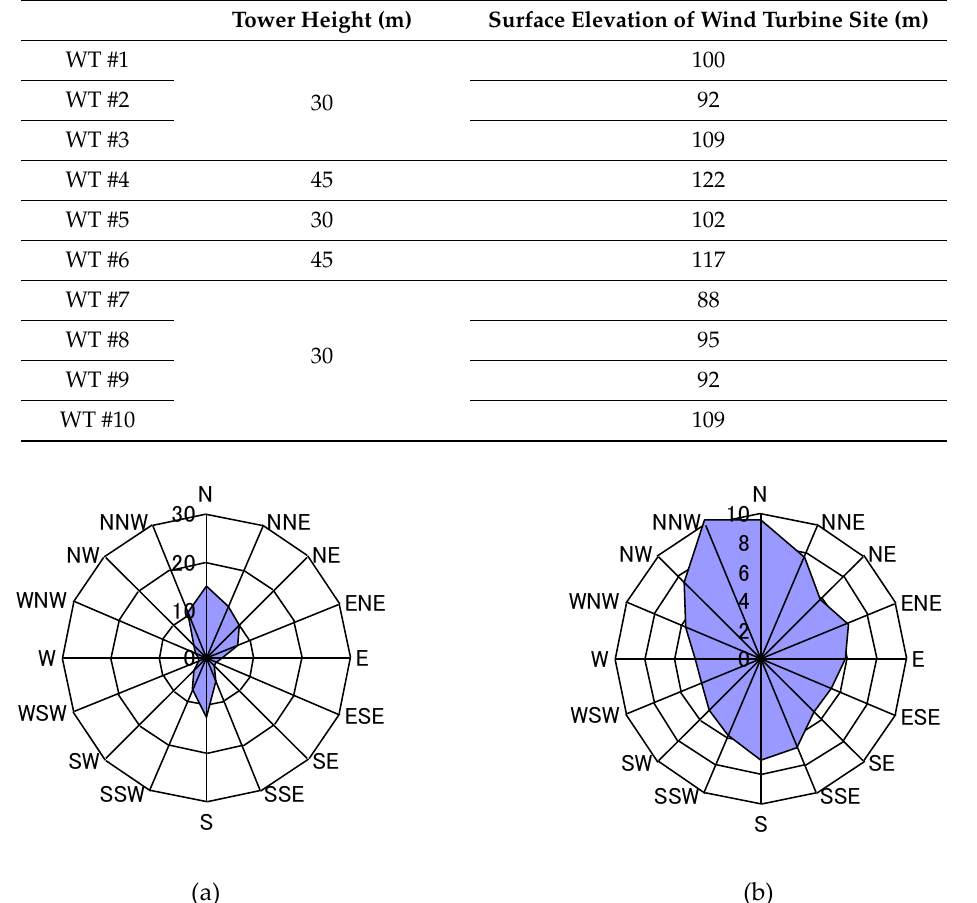
Table 2. Wind turbine (WT) hub heights and surface elevations.